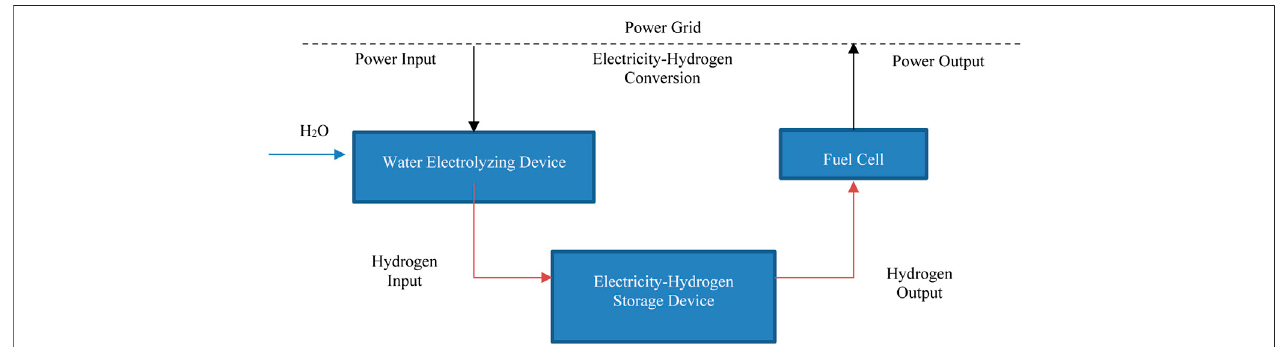
FIGURE 1 | System con fi guration of wind-power